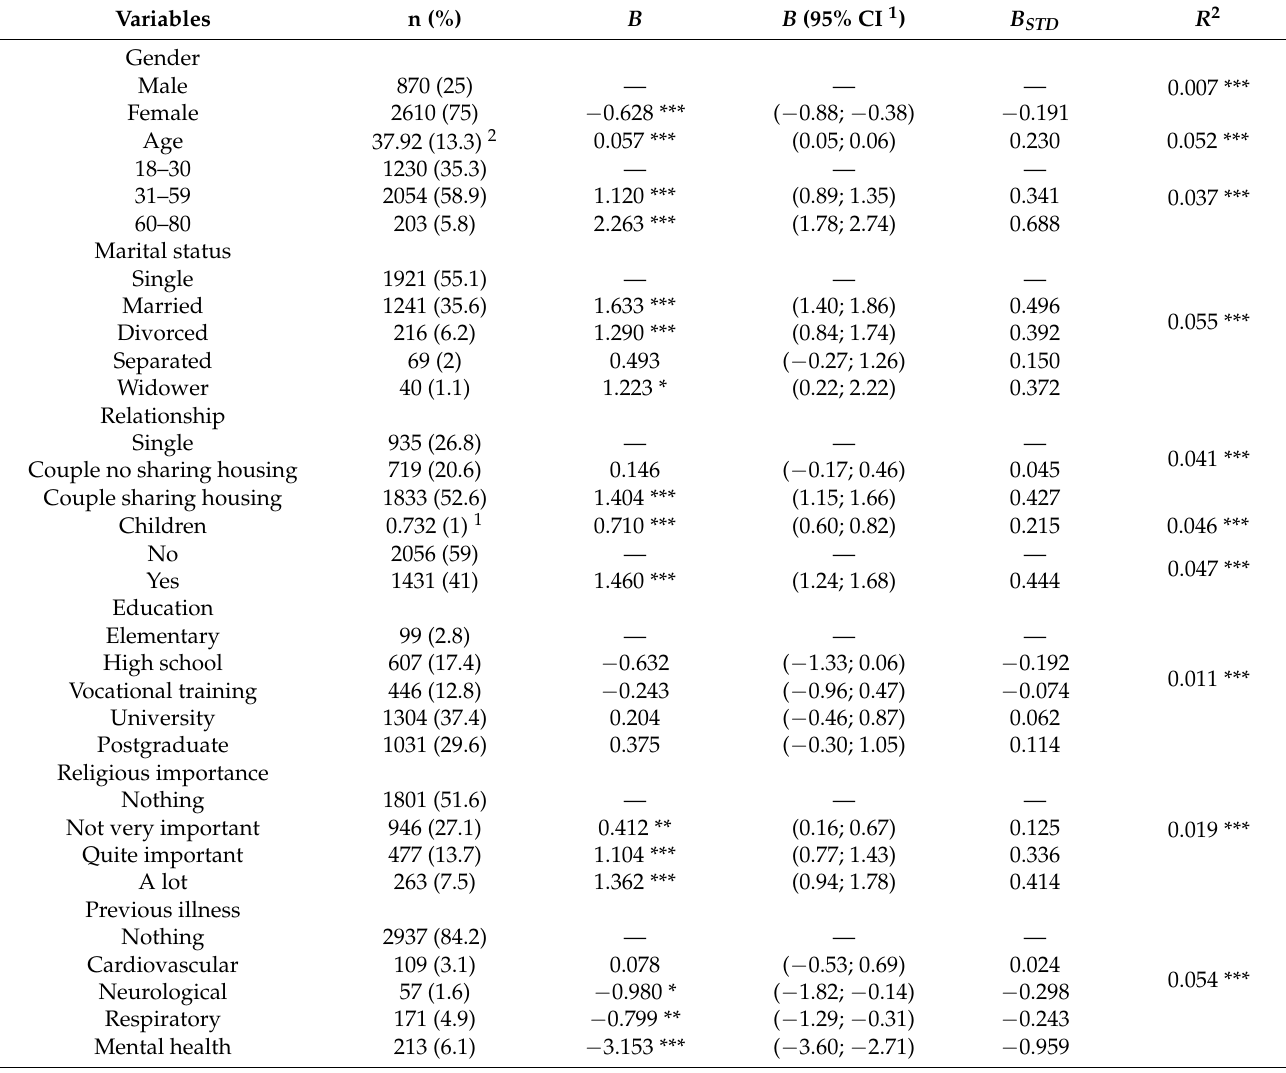
Table 1. Association between sociodemographic variables and peace and